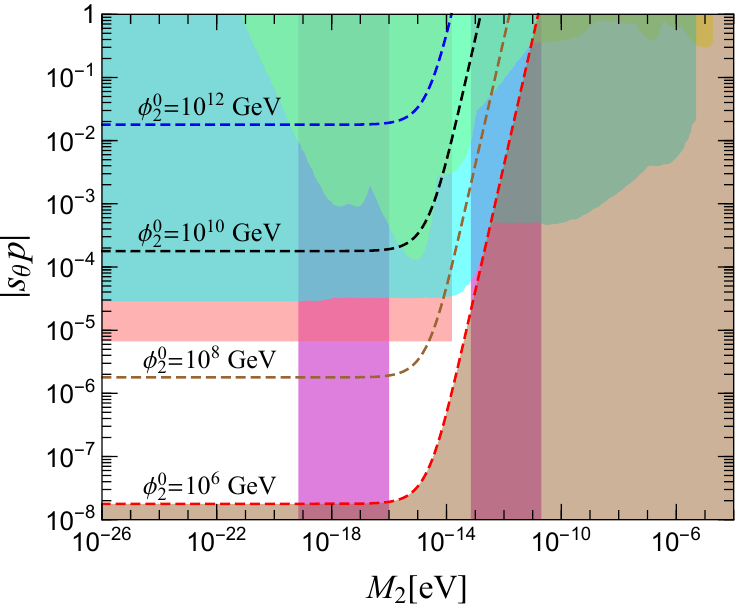
Figure 3 . For (cid:12)xed values of ’ 0 = 10 16 GeV and (cid:30) 0 (cid:17) 2 ’ 0 = ( qc (cid:18) ), contours j (cid:14)m (cid:23) (0) =m (cid:23) j = 0 : 1. 1 2 2 The combination n 0 F ( M (cid:11) R ) is the one of eq. (2.9), with n e ( r ) from refs. [14, 15]. The vertical e bands in purple are excluded from black hole superradiance. The other colored regions are excluded by tests of the Newton law: yellow from test of ISL and blue and pink from tests of the EP, see the discussion in sections 2.1 and 2.3. In the brown region (cid:3) L < 1 TeV, see